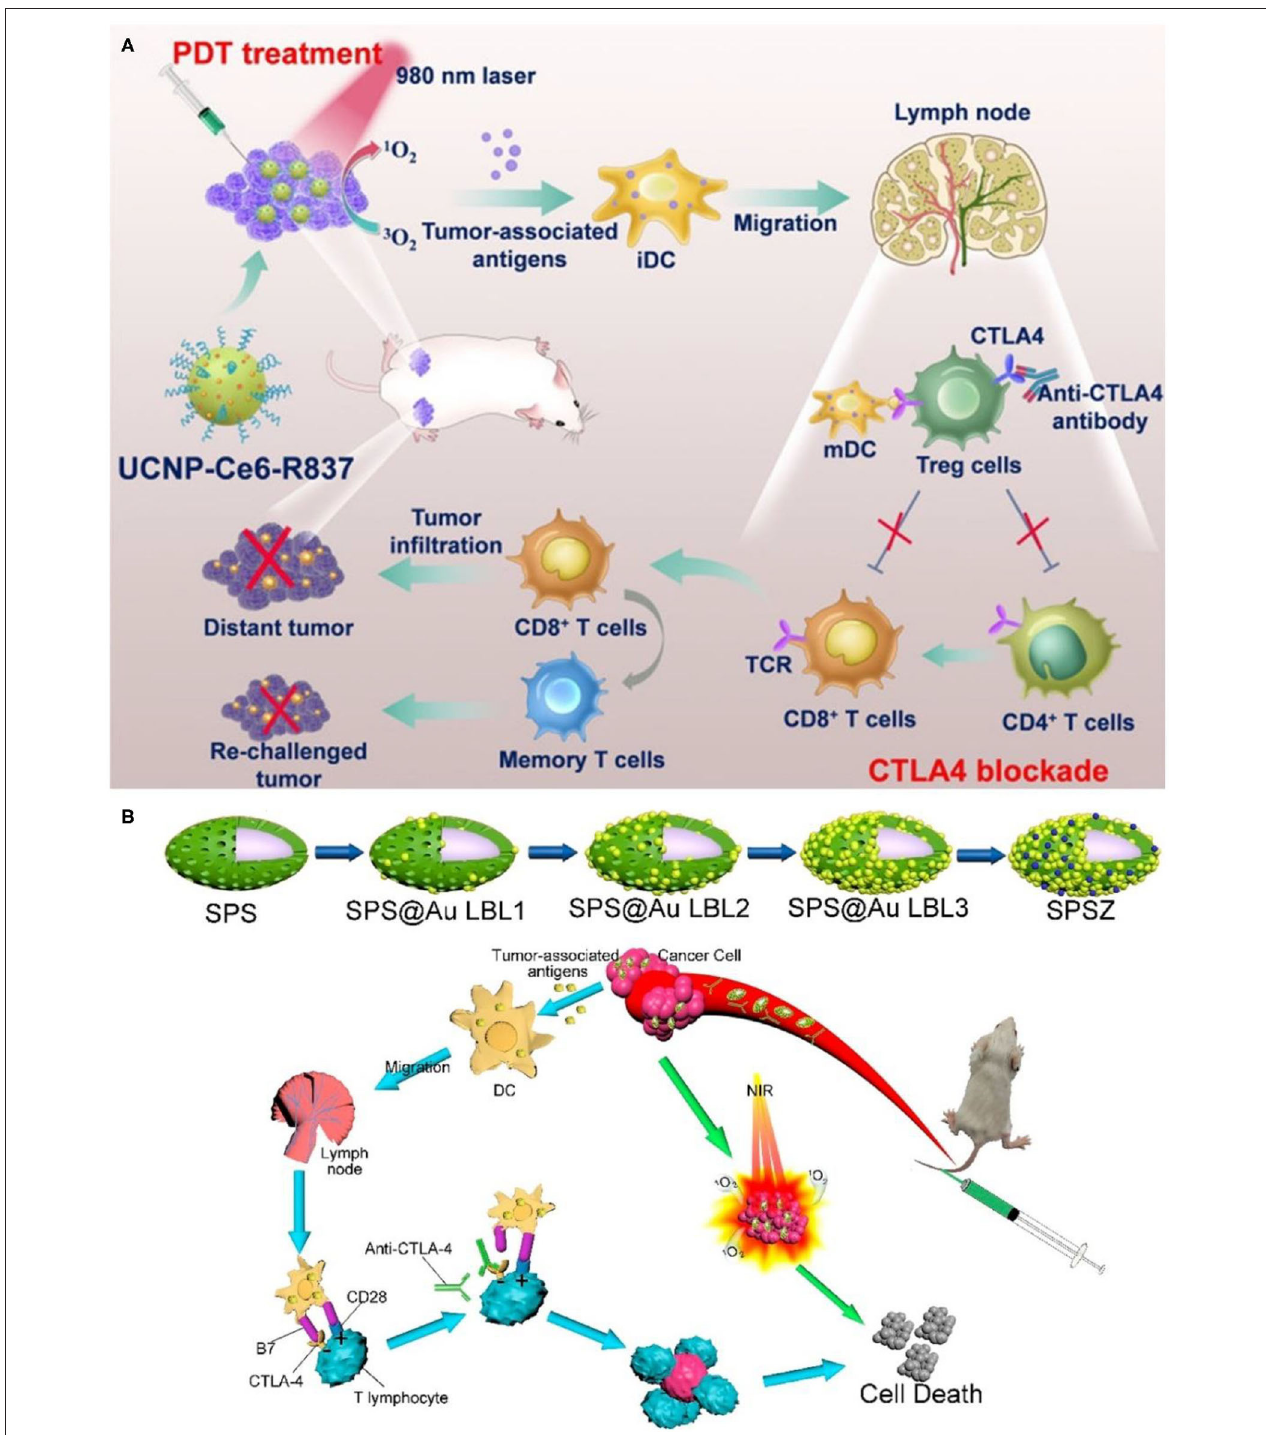
FIGURE 5 | (A) Scheme summarizing the mechanisms of combining NIR-mediated PDT with CTLA-4 checkpoint blockade for cancer immunotherapy. UCNP-Ce6-R837 nanoparticles under NIR light would enable effective photodynamic destruction of tumors. The generated TAA in the presence of those nanoparticles as the adjuvant are able to promote strong antitumor immune responses, which with the help of a CTLA-4 checkpoint blockade would eliminate primary tumors under direct NIR exposure, inhibit the growth of distant tumors left behind after PDT, and further yield a long-term immune memory to prevent tumor reoccurrence. Copyright 2017, American Chemical Society (Xu et al., 2017a). (B) Schematic diagram of spindle-like of UCNP@SiO 2 @Au synthesis and anticancer therapy. Copyright 2020, American Chemical Society (Lin et al., 2020).